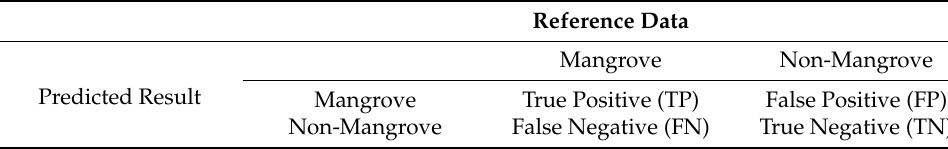
Table 5. Confusion matrix for evaluation